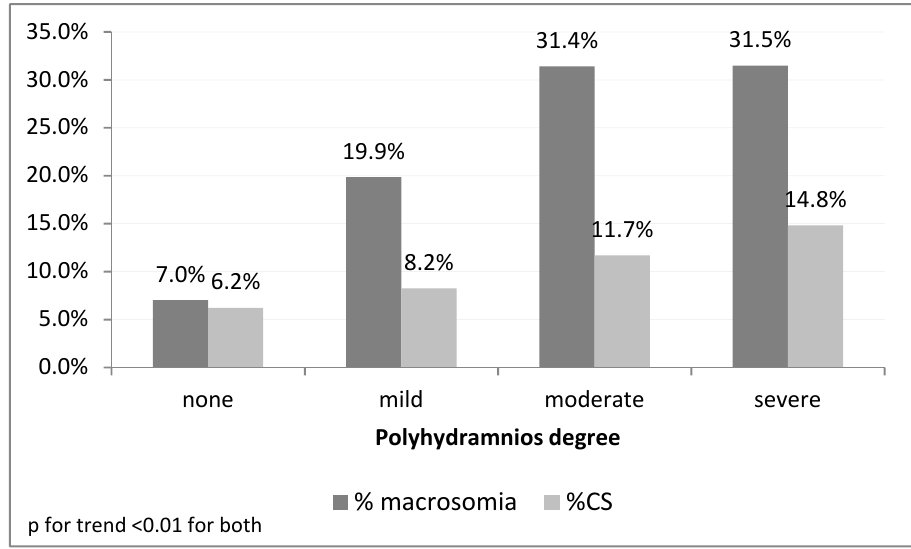
Figure 1. Rates of macrosomia and Cesarean delivery by polyhydramnios degree. Mild: AFI 24–29.9 cm or DVP of 8–11.9 cm; Moderate: AFI 30–34.9 cm or DVP of 12–14.9 cm; Severe: AFI > 35 cm or DVP > 15 cm.